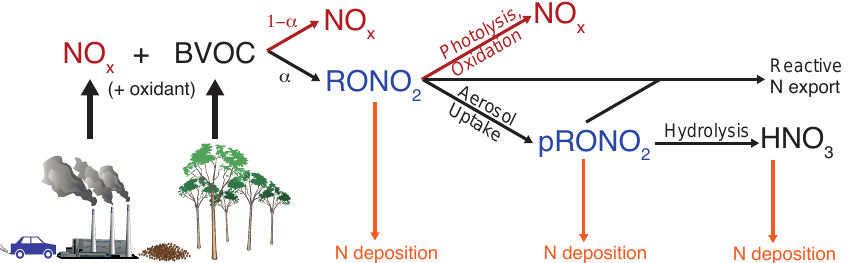
Figure 1. Schematic representation of organic nitrate chemistry and impacts. Organic nitrates are shown in blue, NO x and processes that recycle NO x are shown in red, and nitrogen deposition is shown in orange. Symbols courtesy of the Integration and Application Network, University of Maryland Center for Environmental Science